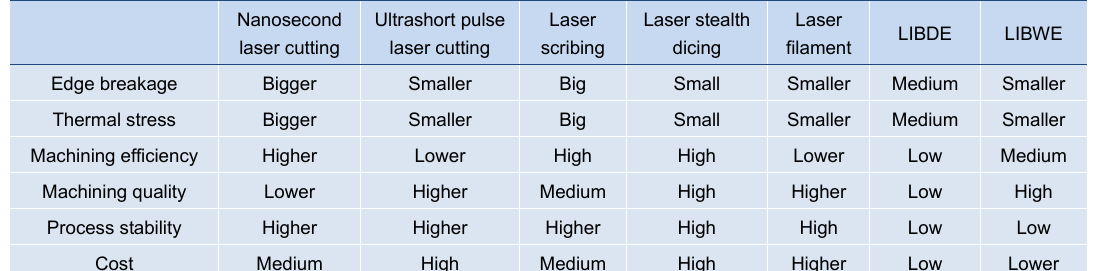
Fig. 9 | ( a ) Experimental device for acquiring pressure signals. ( b ) The whole acquisition time of the pulse pressure signals. ( c ) The part of the pressure signals under single-pulse. Laser energy density of 90.94 J/cm 2 , solution concentration of 1 mol/L, pulse width of 100 ns, detection distance of 2 mm, laser repetition frequency of 2.5 kHz. Figure reproduced from ref. 72 . Table 1 | Comparison of various laser machining methods for transparent brittle materials.